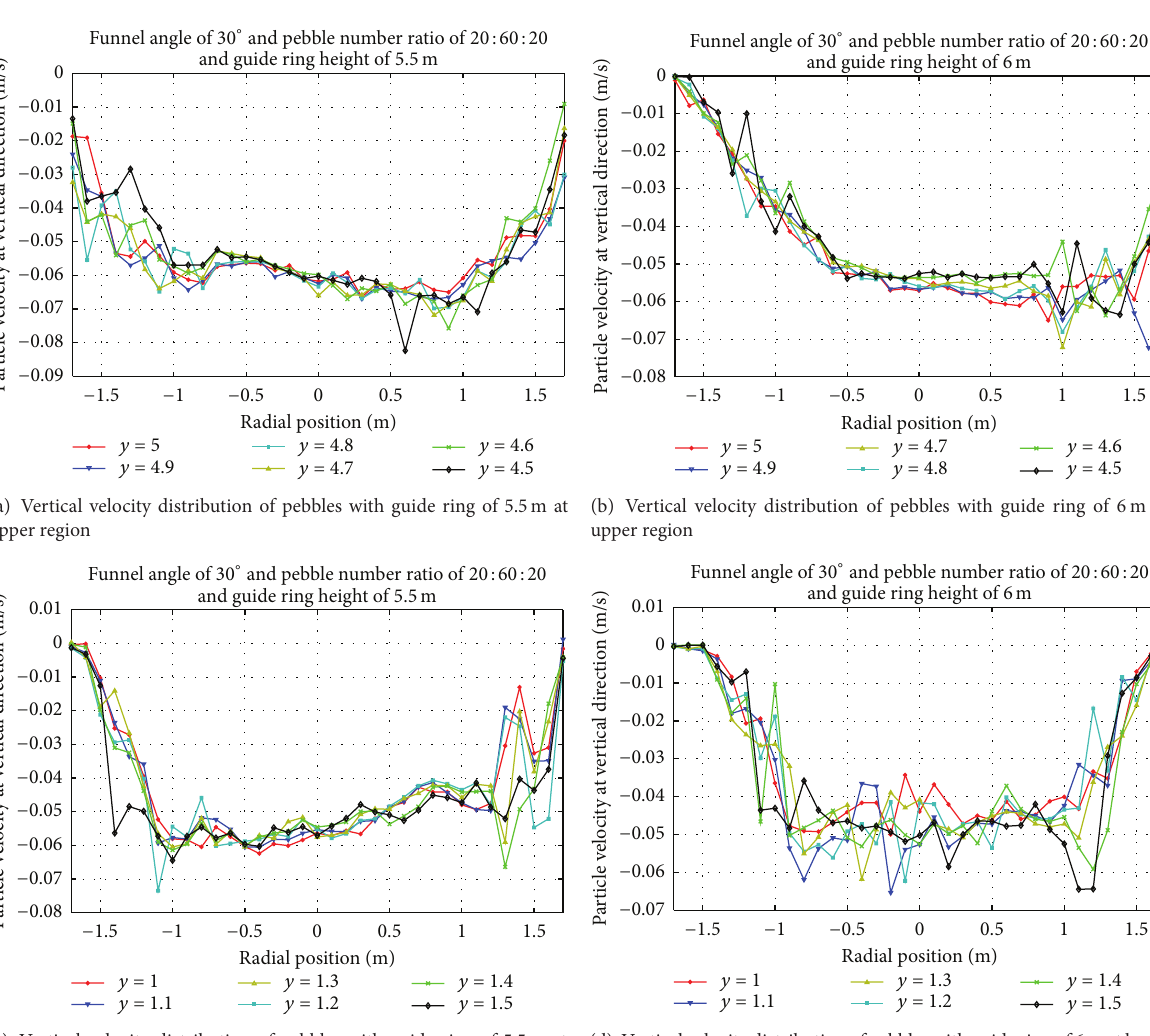
(c) Vertical velocity distribution of pebbles with guide ring of 5.5m at lower region mFunnel angle of 30 ∘ and pebble number ratio of 20 : 60 : 20 and guide ring height of 5.5